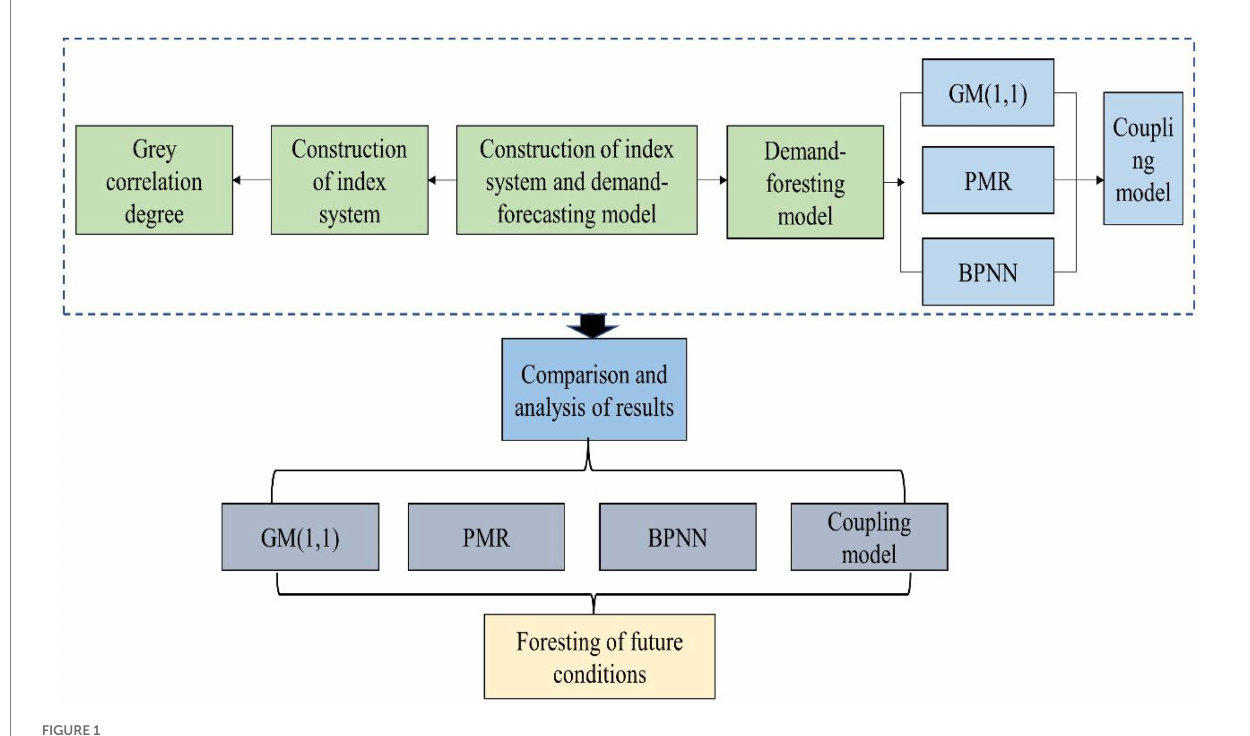
FIGURE 1 Workflow of